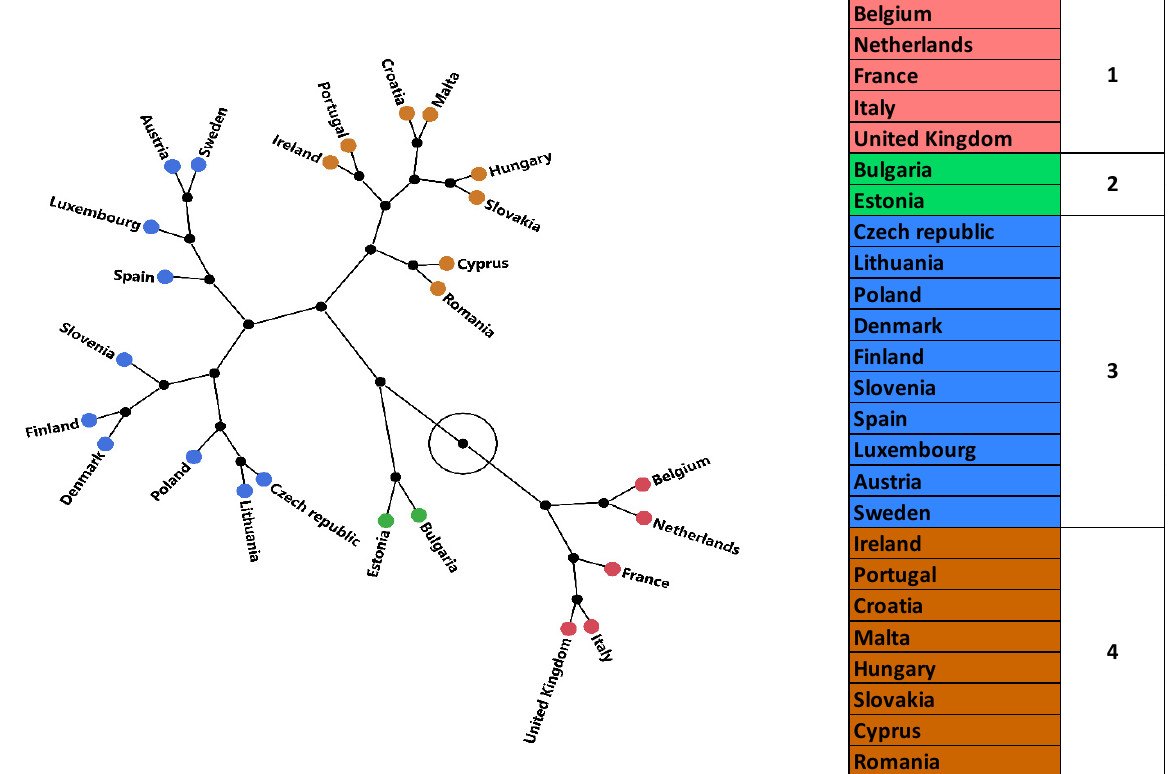
Figure 5. Results of cluster analysis in EU states according to the effectiveness of resource use in 2016. (Own processing according to ES data in software JMP, Excel).